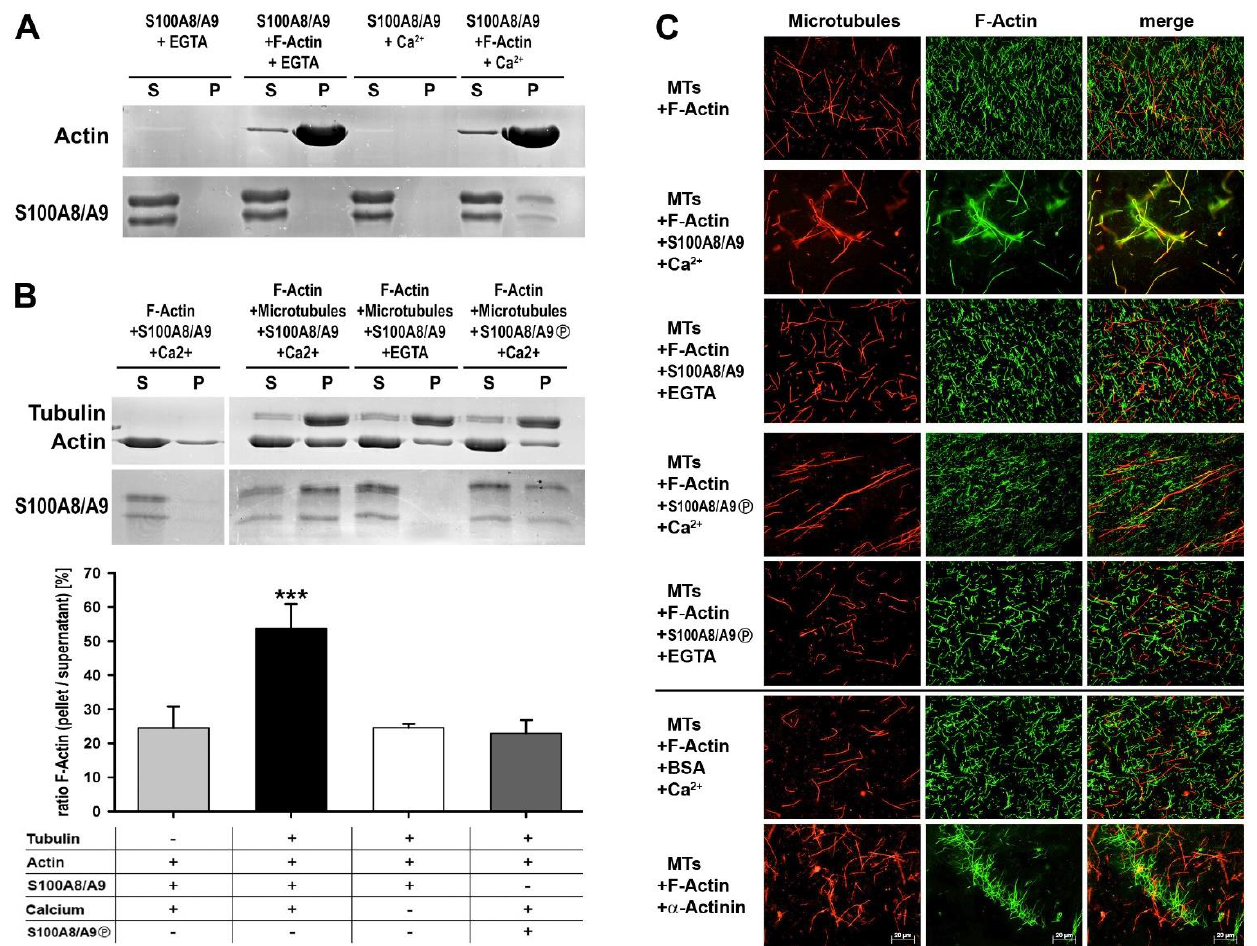
Figure 2. S100A8/S100A9 cross-linked actin filaments and MTs. ( A ) Co-sedimentation assay of prepolymerized F-actin in the presence of S100A8/S100A9 analyzed by SDS-PAGE (S = supernatant; P = pellet). S100A8/S100A9 in its calcium-loaded state bound to F-actin and was subsequently found in the pellet fraction after centrifugation (100,000× g /1 h). ( B ) Co-sedimentation assay and densitometric analysis of prepolymerized MTs in the presence of S100A8/S100A9 or S100A8/phospho- S100A9 and actin filaments analyzed by SDS-PAGE (centrifugation conditions 10,000× g /1 h). Only calcium-loaded S100A8/S100A9 caused increased sedimentation of F-actin, indicating MT/F-actin cross-linking. On the other hand, MT/F-actin cross-linking was diminished by the phosphorylation of the S100A8/S100A9 complex. ( C ) The fluorescence in vitro assay confirmed cross-linking of rhodamine-labeled MTs (red) and FITC-phalloidin labeled F-actin (green) by the S100A8/S100A9 complexes. It also revealed parallel alignment of the individual filaments. Again, only calcium-loaded S100A8/S100A9 was able to cross-link F-actin and MTs, while the phosphorylation of S100A9 abrogated cross-linking under the same conditions. BSA served as the unspecific negative control and α -actinin, which is known to bundle F-actin but not MTs, served as the positive control. ( n = 3; mean ± SD; *** p < 0.001).